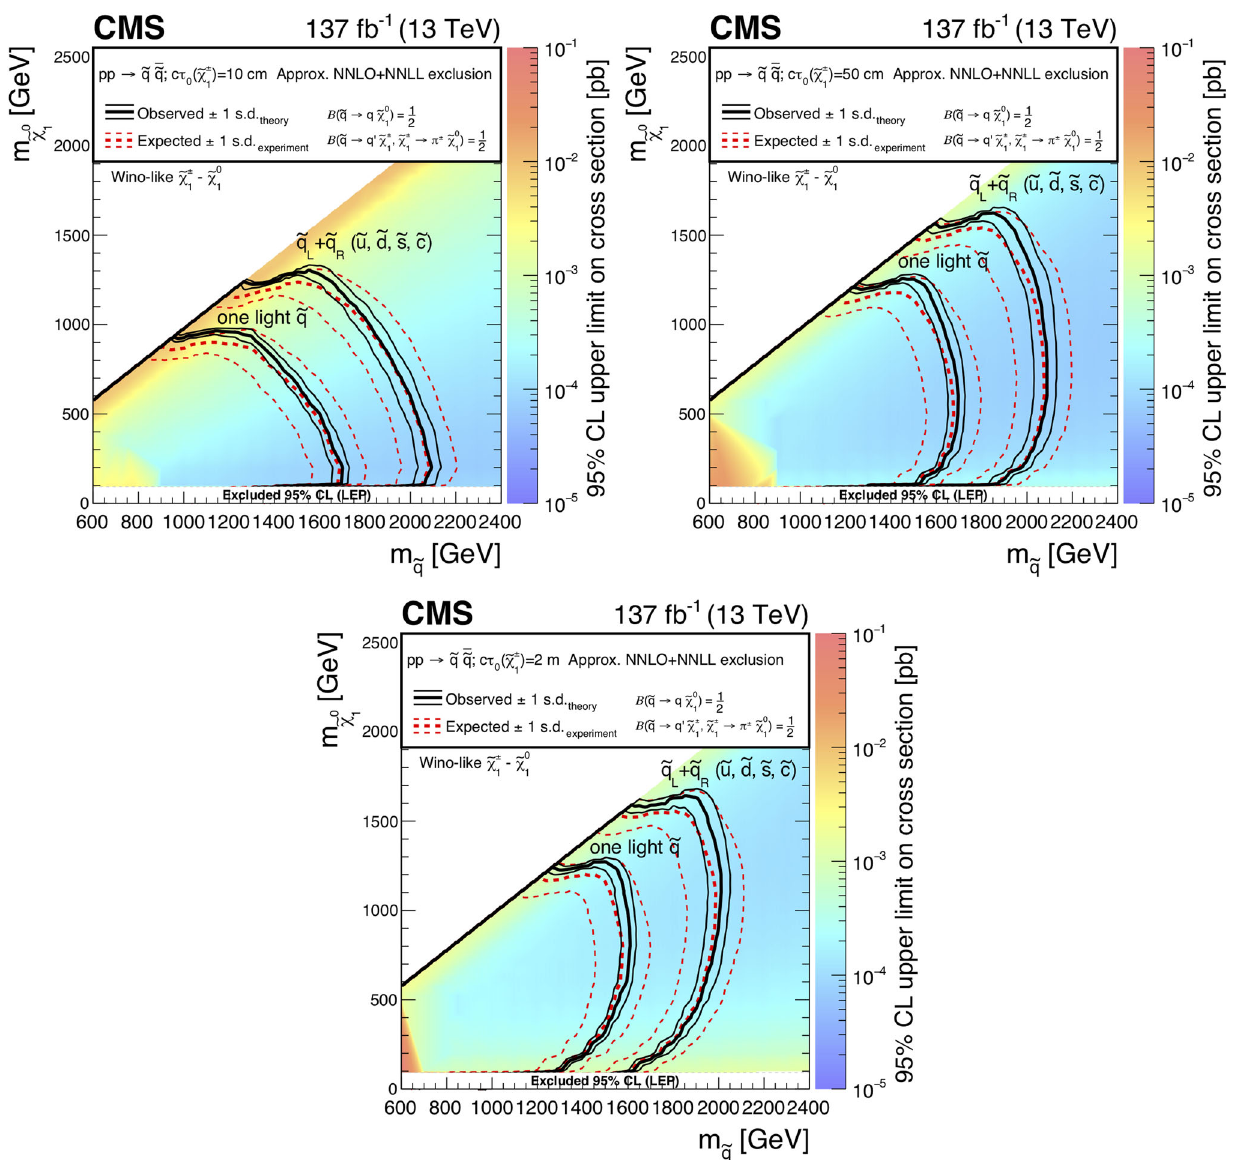
Fig. 18 Exclusion limits at 95% CL for light squark pair production ) = (upper left) 10cm, (upper right) 50cm, and (lower) with c τ 0 ( ˜ χ ± 1 200cm. The area enclosed by the thick black curve represents the observed exclusion region, while the dashed red lines indicate the expected limits and their ± 1 standard deviation (s.d.) ranges. The thin black lines show the effect of the theoretical uncertainties in the signal